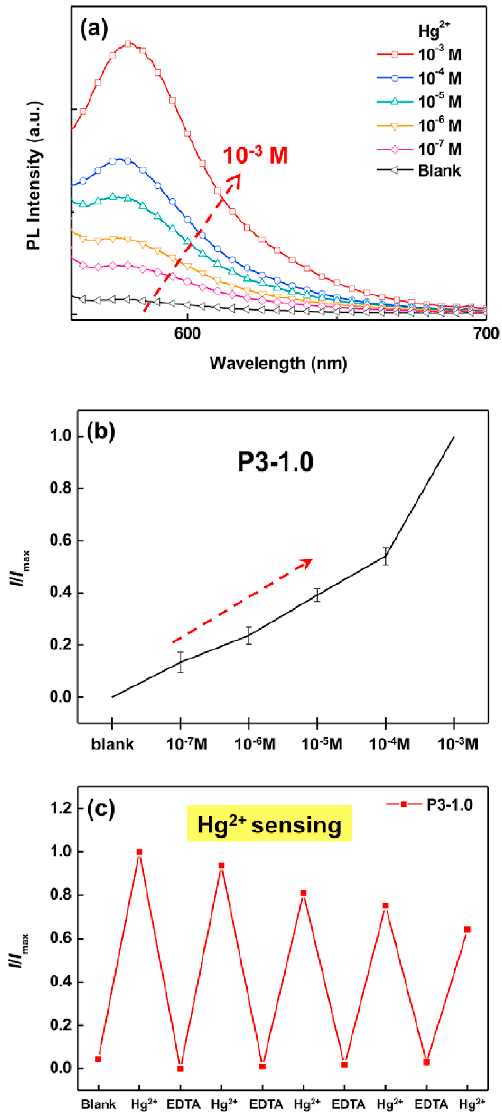
Figure 4. Spectra of ES nanofibers: ( a ) Variation in the PL spectra of P3-1.0 ES nanofibers in aqueous solutions with different molarities of Hg 2+ ions from 0 M to 10 − 3 M. ( b ) Relative trend graph ( I/I max ) of P3-1.0 ES nanofibers. ( c ) Reversibility of the Hg 2+ -dependent “on–off–on” fluorescence intensity profile of P3-1.0 ES nanofibers ( λ ex : 510 nm). Reprinted with permission from [41]. Copyright 2017, Elsevier.